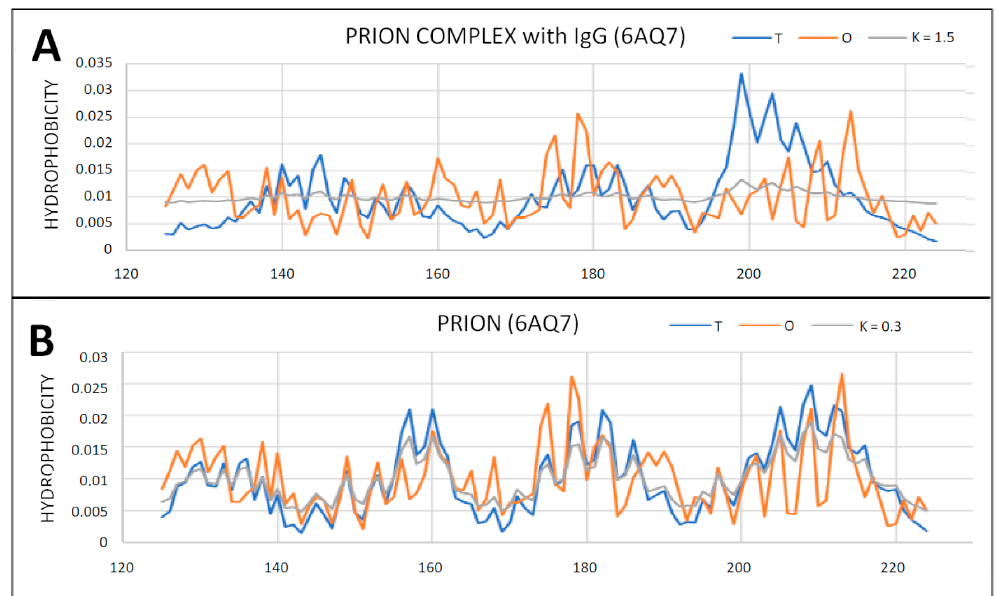
Figure 13. T, O and M profiles for prion protein available in PDB as 6AQ7 deposit. ( A ) Status of the prion protein as a component of the complex with the IgG Fab fragment (3D Gaussian function generated for the entire complex); ( B ) status of the prion protein treated as an individual structural unit (3D Gauss function generated independently for the prion protein).